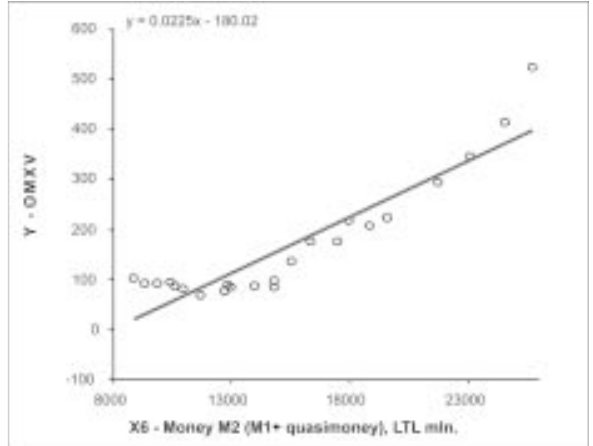
Fig 3. Dependence of OMXV index on GDP (mill.